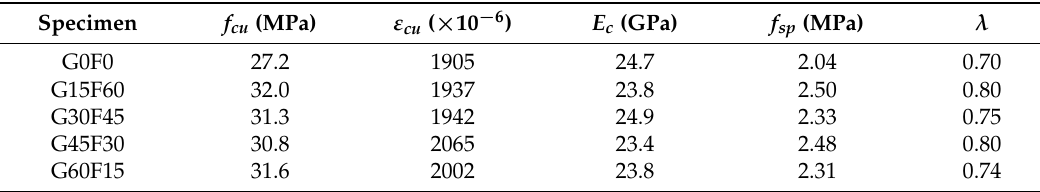
Table 4. Mechanical properties of concrete at